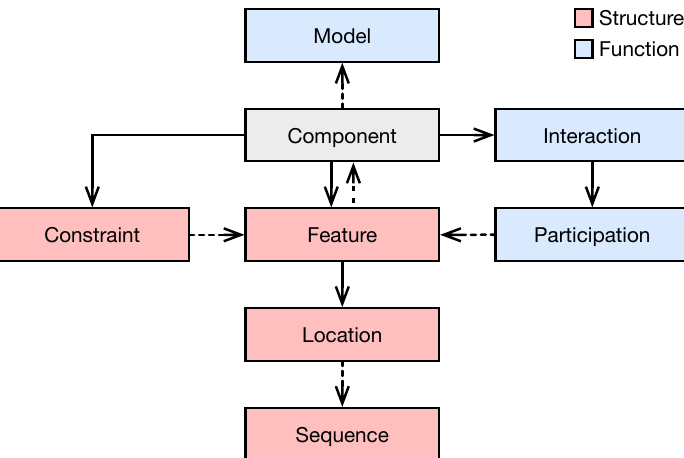
Figure 2: The SBOL Component object and related objects. Solid arrows indicates ownership, whereas a dashed arrow represents a reference to an object of another class. Red boxes represent structural objects, while blue boxes represent functional objects. To represent structural aspects, a Component can include Feature s, which may